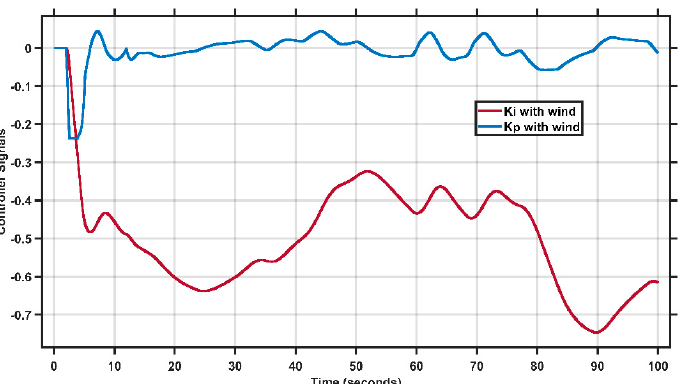
Figure 16. The proposed controller signals under wind disturbance.